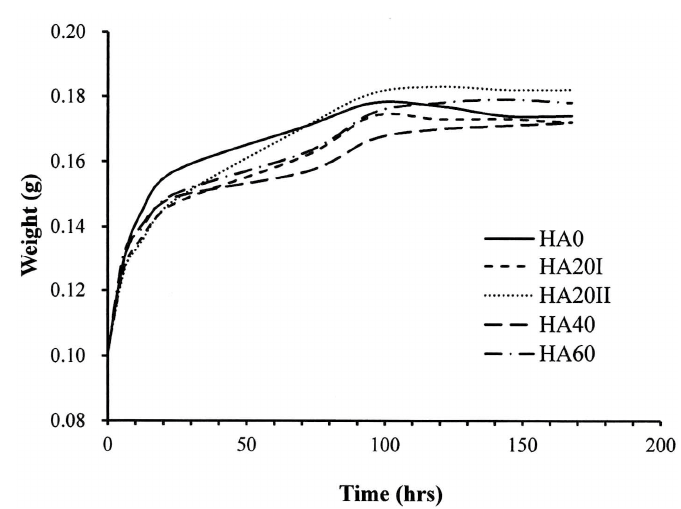
Figure 5. Effect of γ -irradiation on the water-absorbing ability of LMWHA over time.